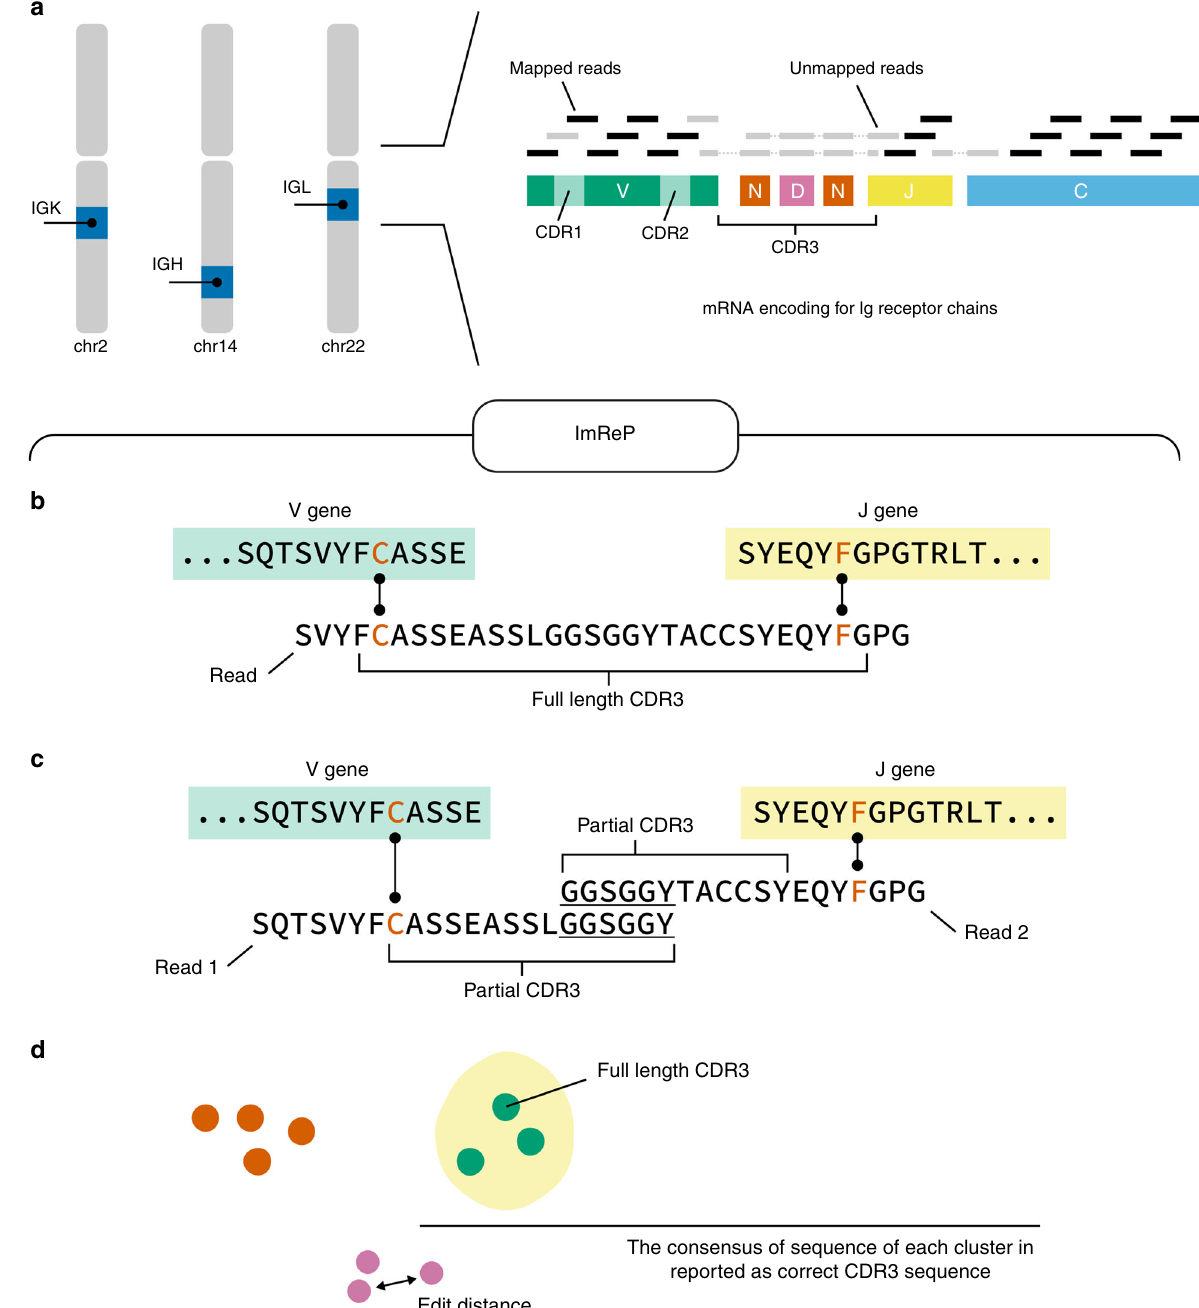
Fig. 1 Overview of ImReP. a Schematic representation of human Ig receptor repertoire. Ig repertoire consists of three Ig loci: immunoglobulin heavy locus (IGH), immunoglobulin κ locus (IGK), and immunoglobulin λ locus (IGL). Ig receptors contain multiple variables (V, green color), diversity (D, which is present only in IGH, violet color), joining (J, yellow color), and constant (C, blue color) gene segments. V(D)J gene segments are randomly joined and non-templated bases (N, dark red color) are inserted at the recombination junctions. Reads entirely aligned to Ig genes are inferred from mapped reads (black color). Reads with extensive somatic hypermutations and reads spanning the V(D)J recombination are inferred from the unmapped reads (gray color). Complementarity- determining region 3 (CDR3) is used to identify Ig receptor clonotypes — a group of clones with identical CDR3 amino acid sequences. b